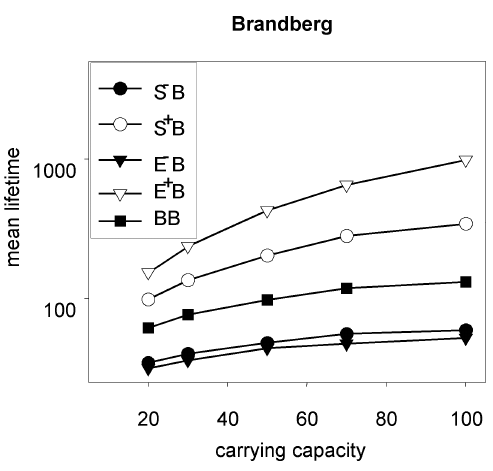
Fig. 3. Mean lifetime vs carrying capacity (adult females) for var- ious sub-scenarios of the natterjack toad population model. Sub- scenarios are derived from the basic “Brandberge” scenario BB. S – B stands for pessimal survival rates, E - B for a pessimal environ- ment, S + B for optimal survival rates and E + B for an optimal envi- ronment.